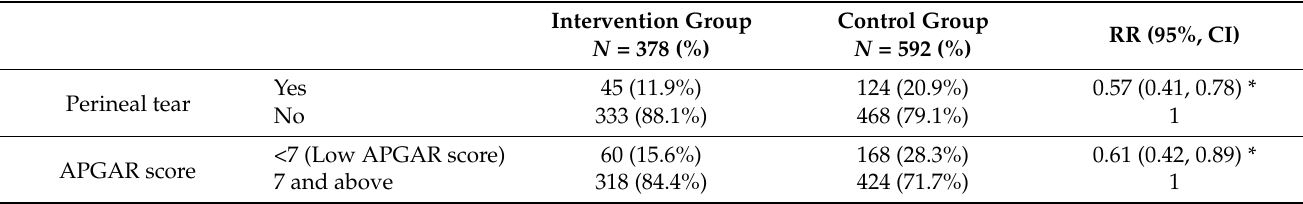
Table 3. Bi-variable Log-binomial regression analysis of effects of the intervention on the risk of perineal tear and Low APGAR score in Amhara Public Health facilities, 2019.